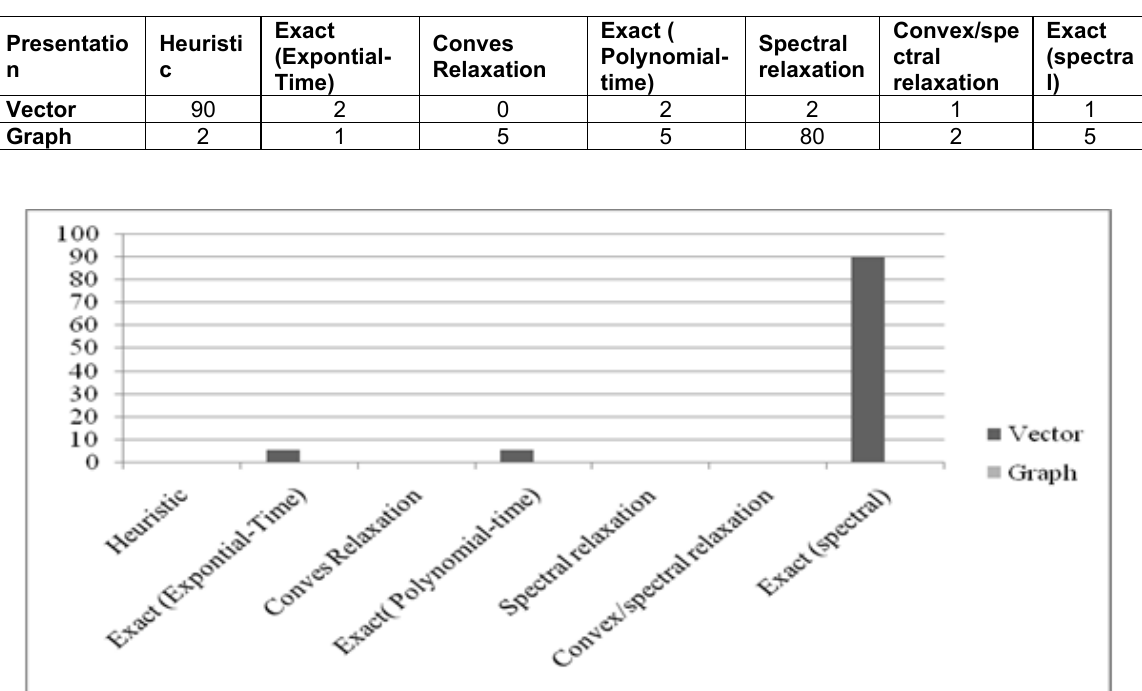
Table 4. Approach in percentage (%) can be applied Model Based framework according to the presentation of the data